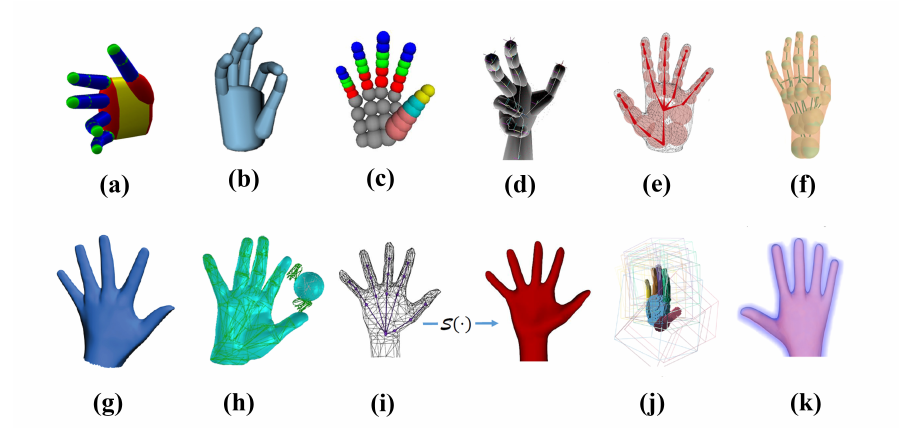
Figure 1. Hand models. ( a ) Capsule model [31–33]. ( b ) Cylinder model [27]. ( c ) Sphere model [23]. ( d ) Convex bodies for tracking [34]. ( e ) Sum of an-isotropic Gaussian model [35]. ( f ) Sphere-mesh model [5]. ( g ) Triangular hand model [4]. ( h ) Triangular mesh [8]. ( i ) Loop subdivision Surface of a triangular control mesh [36]. ( j ) Articulated Signed Distance Function (SDF) for a